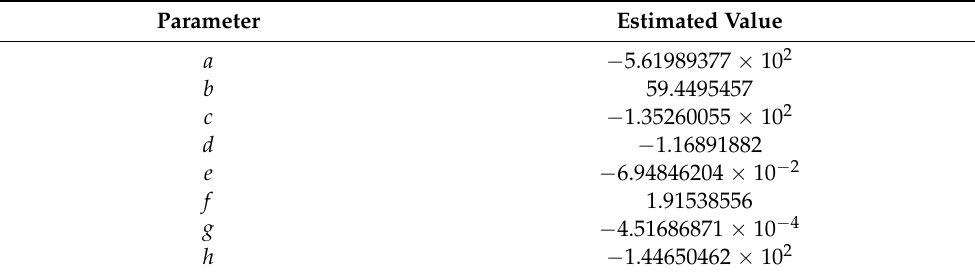
Table 2. Constant values of the modified empirical model.